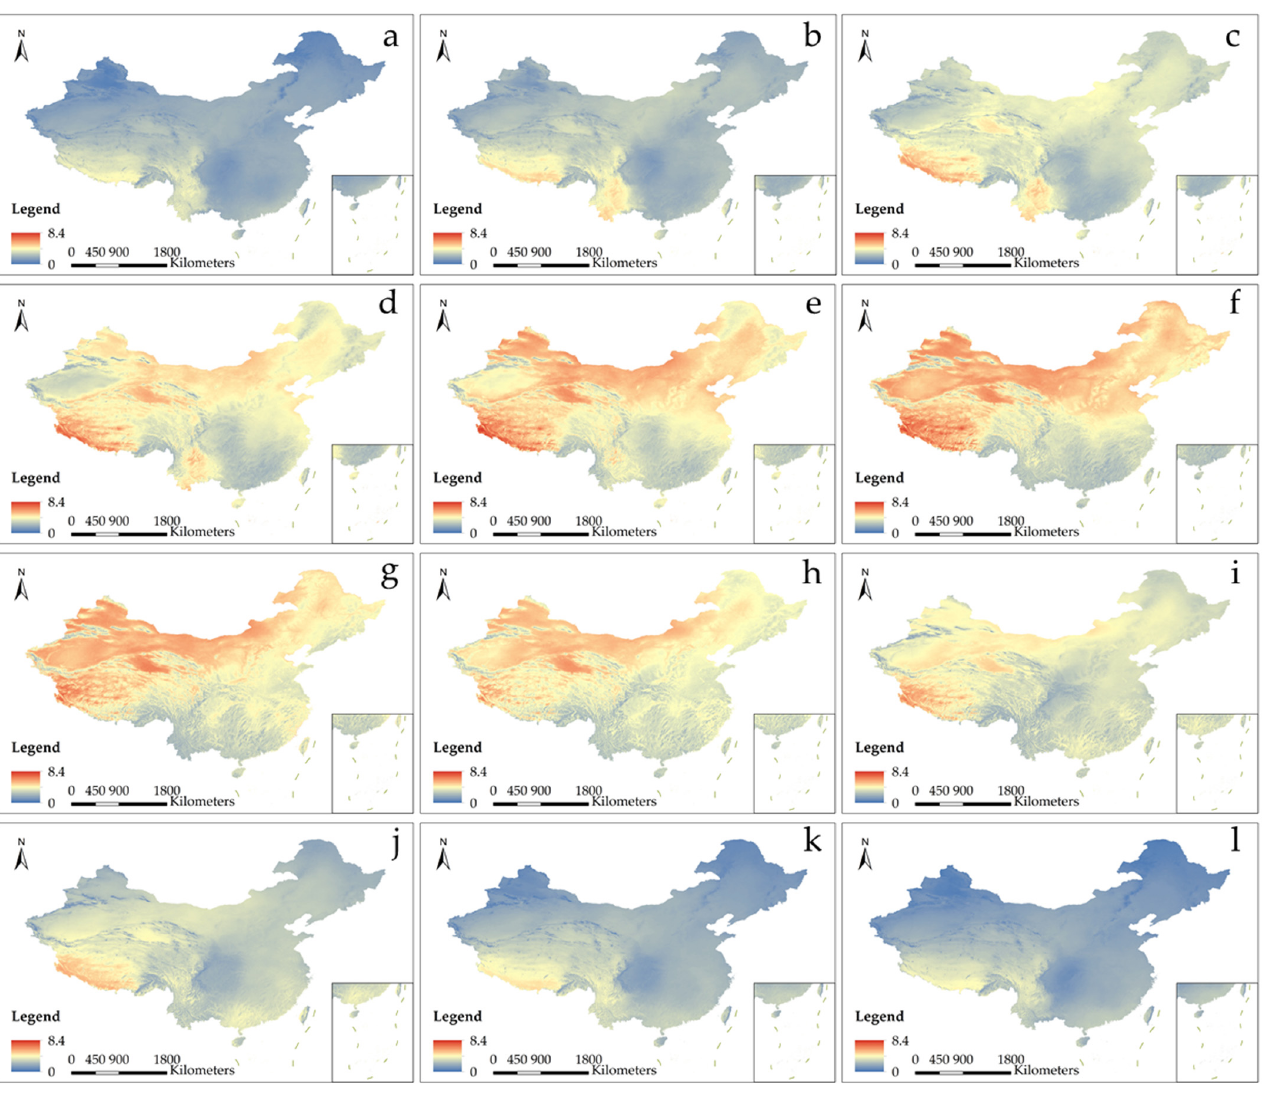
Figure 14. Monthly average daily total PV energy in China. Images ( a – l ) show the monthly average daily total solar radiation from January to December.